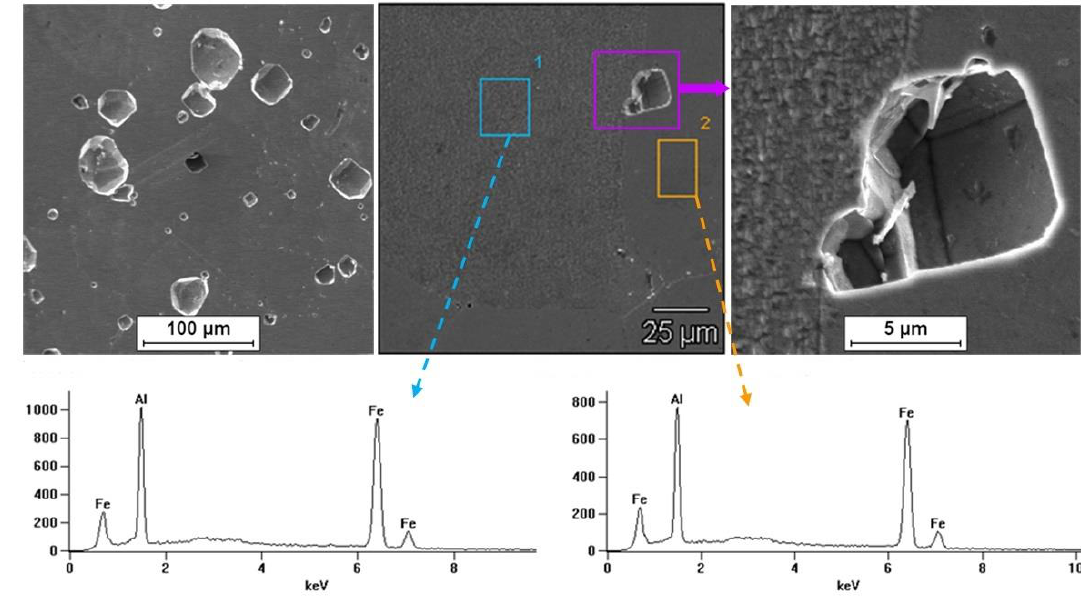
Figure 11. Surface of alloy Fe40Al5Cr0.2TiB after casting and corrosion test.